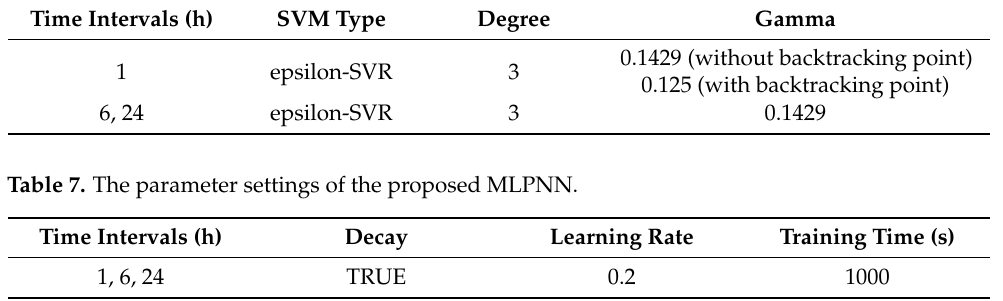
Table 6. The parameter settings of the proposed SVR. Time Intervals (h)